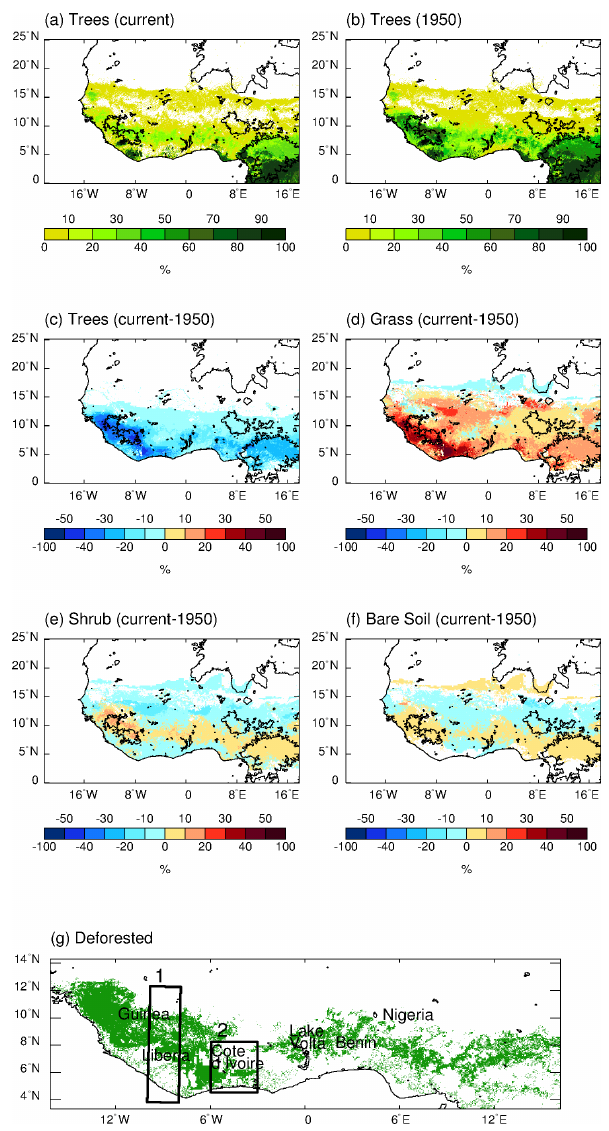
Figure 2. Tree cover for (a) current and (b) 1950s; differences in cover of (c) trees, (d) grass, (e) shrubs, and (f) bare soil (land higher than 500m shown by black contour); and (g) deforestation mask with two sub-regions analysed highlighted with black rectangles. Deforestation is defined as where 1950s tree cover > 30%, current tree cover < 30%, and change in tree cover >